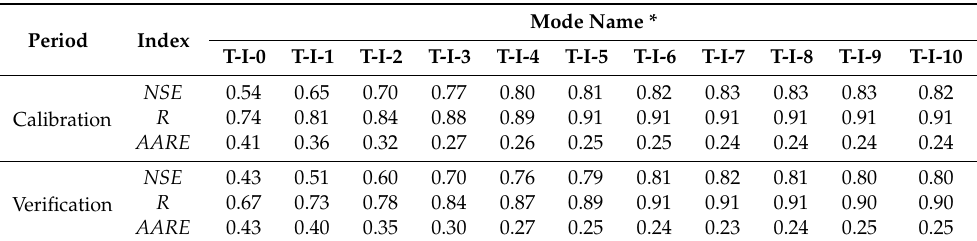
Table 2. Modeling results of WA-ANN models when using the T-I decomposition type.